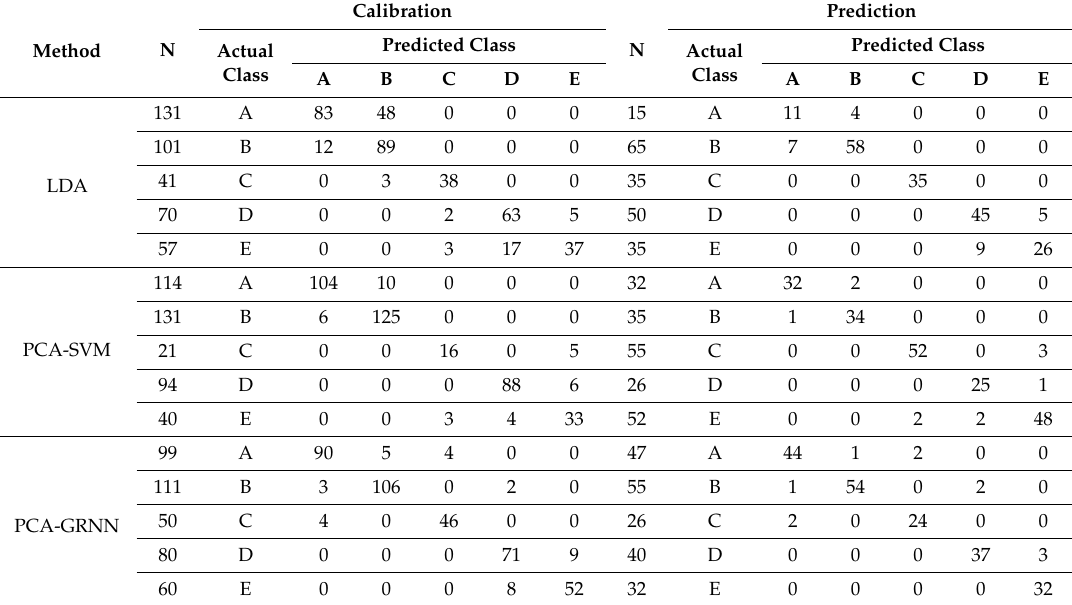
Table 4. Confusion matrix of the samples in the